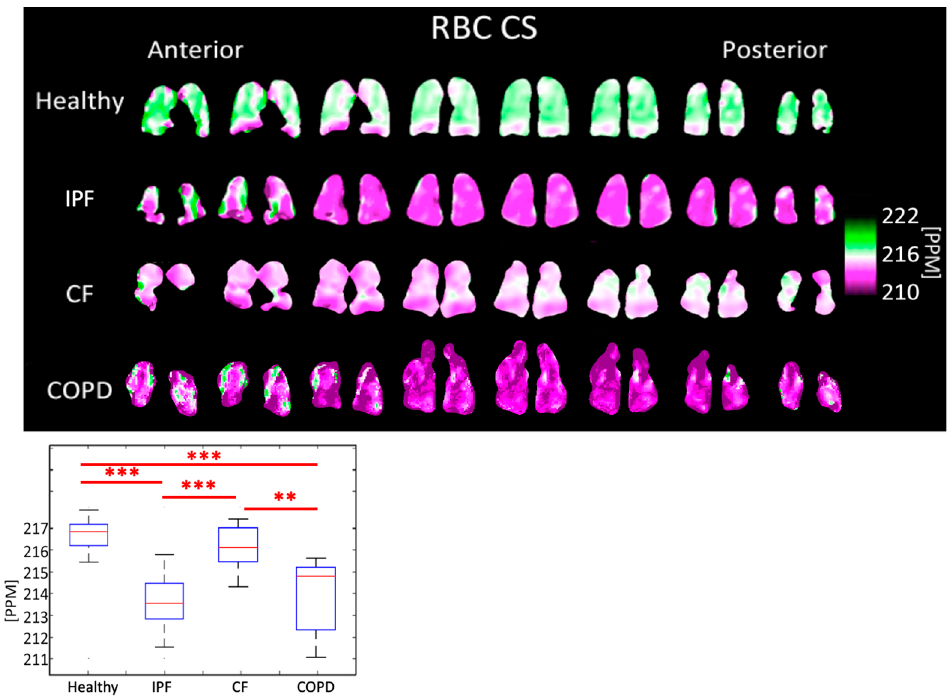
Figure 9. RBC chemical shift maps ( top ) and boxplots ( bottom ) for each disease type. The color bar corresponds to the location of the geometric center of the RBC peak. ( p < 0.001 = ***, p < 0.01 = **) . The separation between RBC and tissue peaks was 16.13 ± 1.208 PPM for IPF subjects, 18.34 ± 0.859 PPM for CF subjects, 16.34 ± 1.884 PPM for COPD subjects, and 18.90 ± 0.628